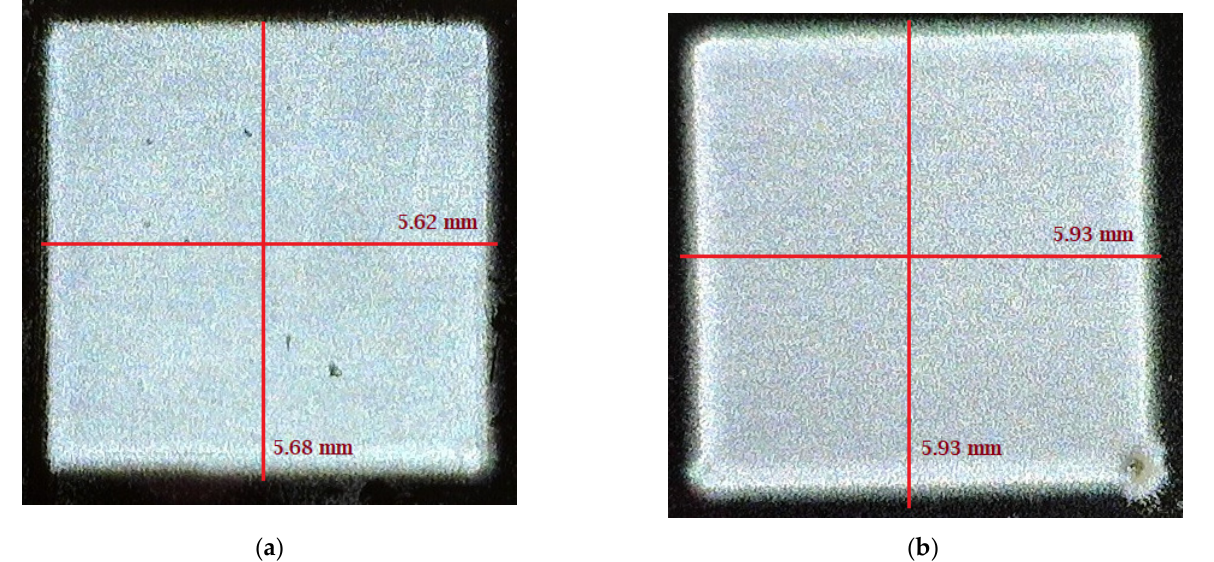
Figure 5. 2.5% PVA printed on Silicon substrate: ( a ) Two printed layers; ( b ) four printed layers.